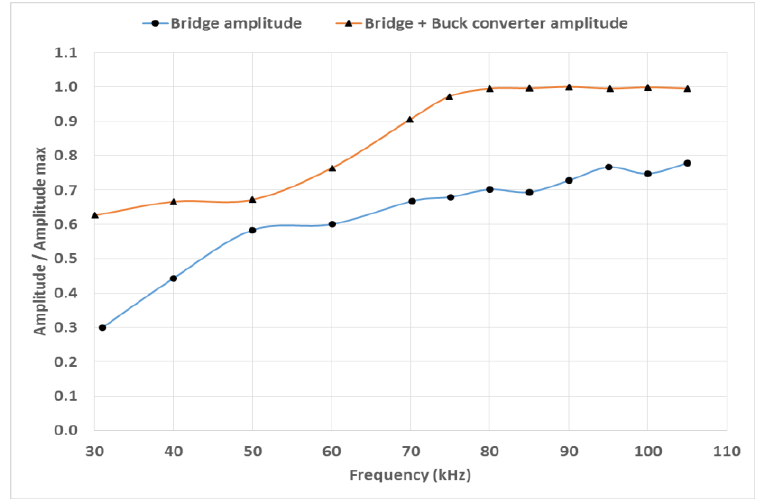
Figure 19. Signal amplitude for both FB and FB+buck converter vs pulse frequency.